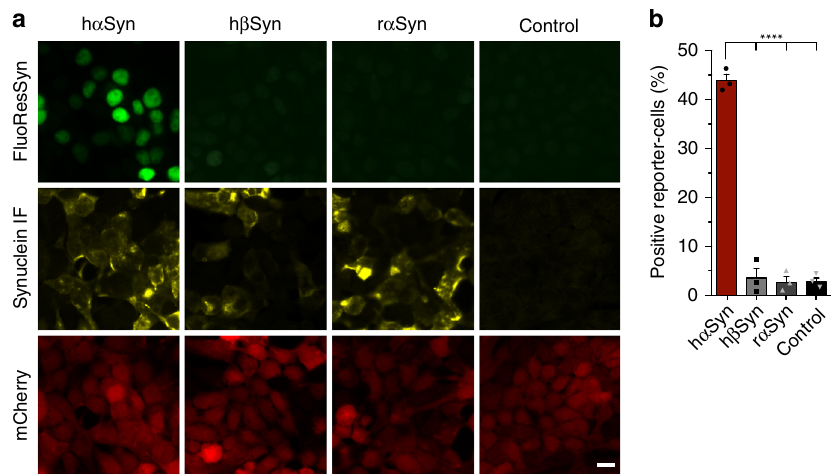
Fig. 4 The FluoReSyn is a speci fi c sensor for human α Syn. a Equally scaled representative epi fl uorescence images of Reporter-cells transfected with h α Syn, h β Syn, or r α Syn expression constructs. Scale bar represents 10 µ m. b Quanti fi cation of the proportion of EGFP-positive cells. Error bars represent the SEM from the independent experiments ( n = 3). Per replication and condition >6000 cells were analyzed. Ordinary one-way ANOVA resulted in **** p < 0.0001. Source data is available as a Source data fi le.